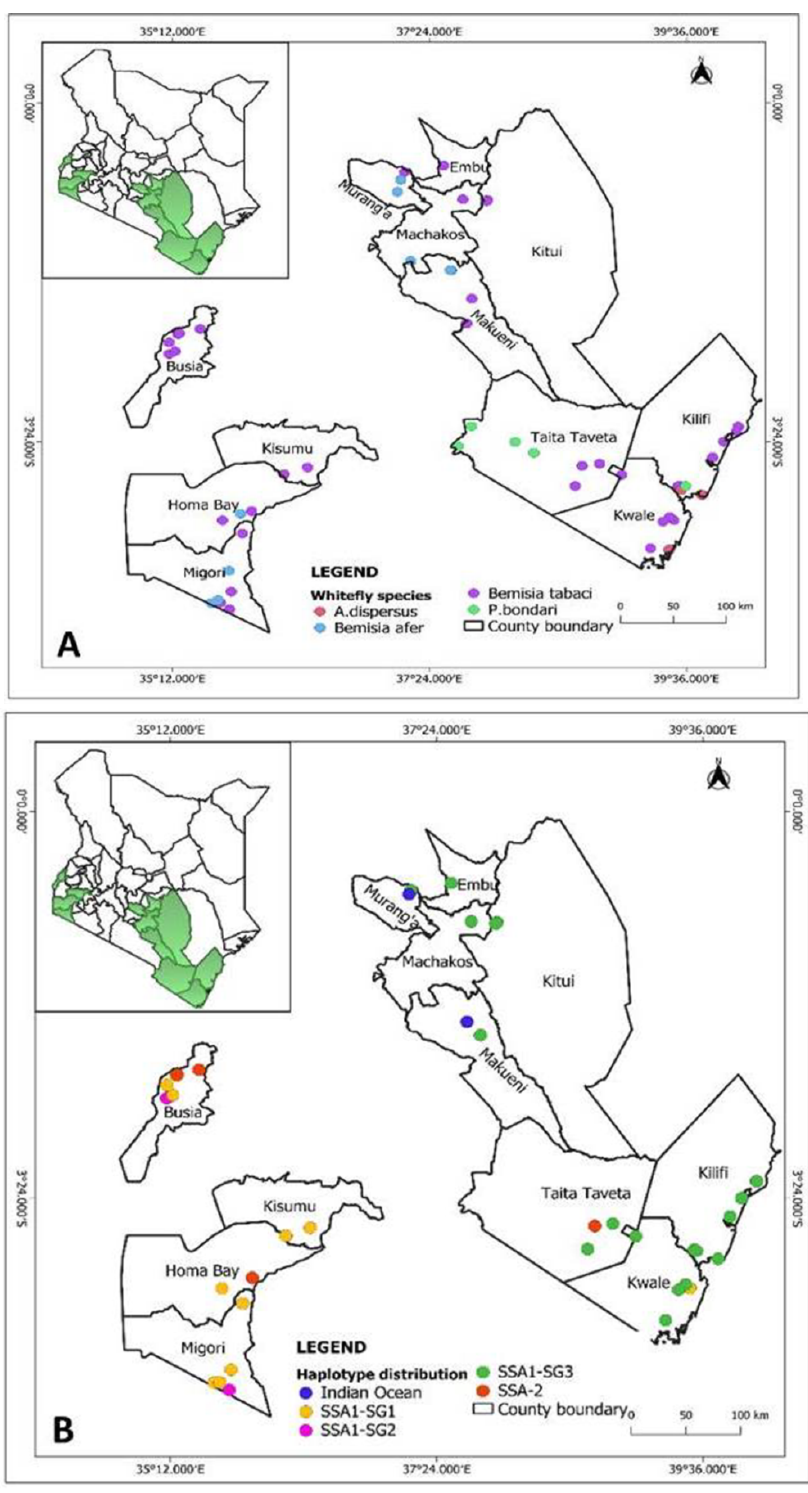
Figure 5. A map of Kenya and cut-out maps of cassava growing counties in Kenya showing distri- bution of the four whitefly species ( A ) and B. tabaci haplotypes ( B ) of cassava-colonizing whitefly identified from the samples collected during the study.